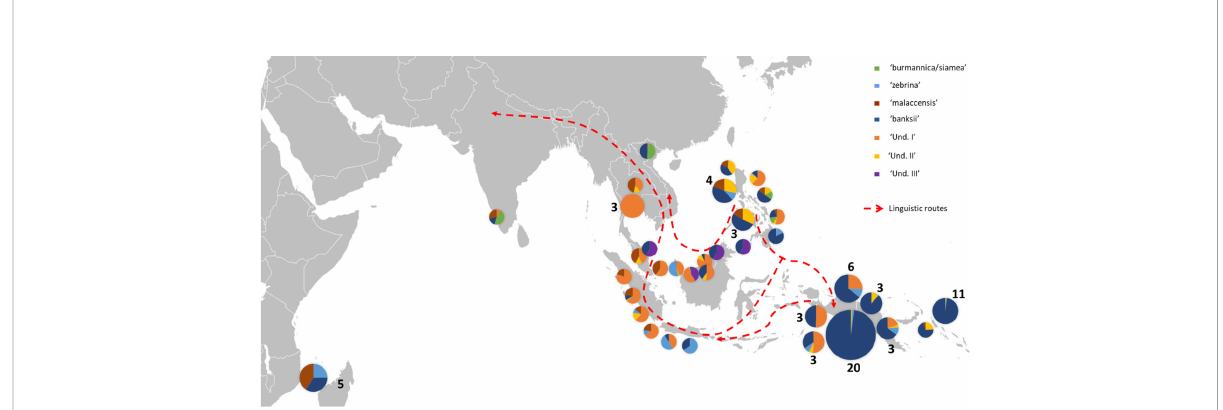
FIGURE 3 Distribution of cultivated AA accessions of the samples. The pie charts illustrate genomic background (as inferred by STRUCTURE for k=8) and the numbers indicate the number of accessions sharing similar patterns. Dashed red lines show linguistic paths for the words ‘ banana ’ in the region as inferred by Perrier et al. (2011). The historical movements of these terms re fl ect ancient spread of Musa cultivars in the